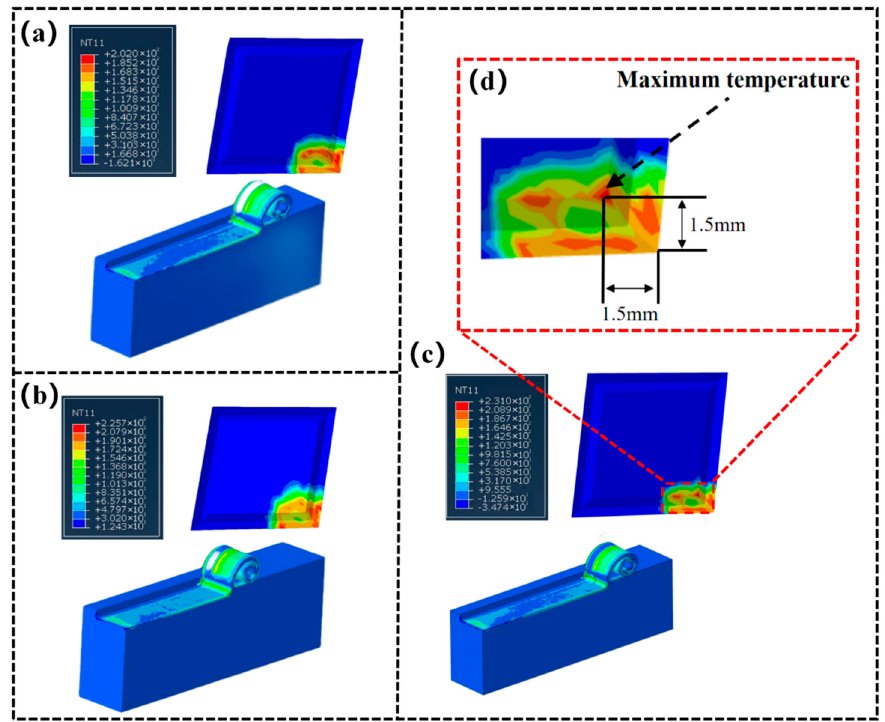
Figure 2. Temperature simulation results of tool and workpiece under different parameters. ( a ) A cutting speed of 113.04 m/min. ( b ) A cutting speed of 150.72 m/min. ( c ) A cutting speed of 188.40 m/min. ( d ) Position of highest milling temperature.